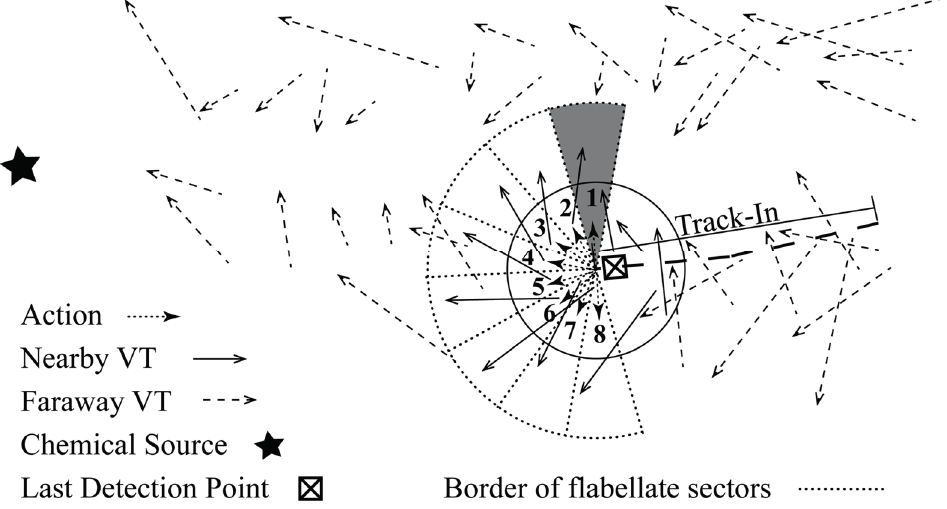
Figure 6. Q-value approximation based on nearby VTs. The solid circle encloses the neighboring area of the starting state in the following Track-Out activity, i.e. , .s u